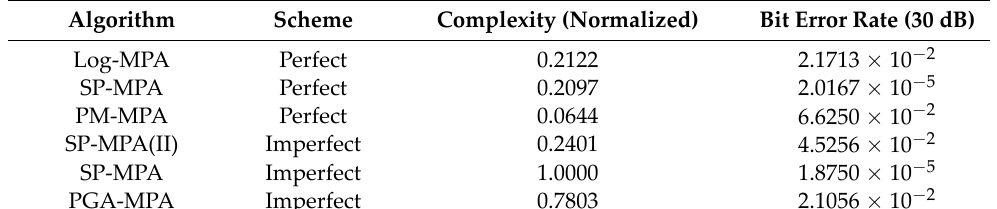
Figure 19. Convergence of the codeword probability.